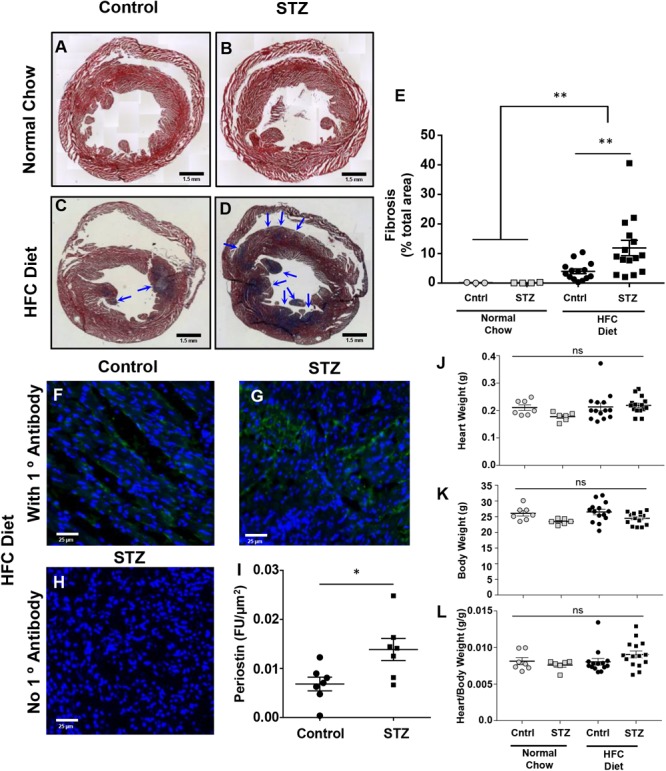
Effects of STZ- treatment on myocardial fibrosis in HFC diet fed SR-B1-KO/hypoE mice. Representative composite images of cardiac cross sections from (A) control- and (B) STZ-treated mice fed the normal chow diet and analyzed 14 weeks after the start of treatment, or (C) control- and (D) STZ-treated mice fed the HFC diet beginning 3 weeks after the start of treatment and analyzed after 4 weeks of HFC diet feeding. Sections are stained with Mason’s trichrome – healthy myocardium stains red and collagen stains blue (arrows). Scale bars represent 1.5 mm. (E) Quantification of average fibrotic (blue) area per section. Representative images of periostin staining (green) of cardiac sections from (F) control- and (G) STZ-treated mice fed the HFC diet beginning 3 weeks after the start of treatment and analyzed after 4 weeks of HFC diet feeding. (H) Control section of heart from an STZ-treated mouse fed the HFC diet in which the primary anti-periostin antibody was left out. Sections were counterstained with DAPI (blue). Scale bars represent 25 μm. (I) Quantification of periostin staining intensity per cardiac cross-sectional area for control- or STZ-treated mice that had been fed the HFC diet. (J) Heart weights, (K) body weights, and (L) heart/body weight ratios for control-treated (circles) and STZ-treated mice (squares) either maintained on the normal chow diet for 14 weeks after control/STZ-treatment (gray symbols) or fed the HFC diet for 4 weeks, beginning 3 weeks after control/STZ-treatment (black symbols). Each symbol in E and I–L represents an individual mouse. Means ± SEM are indicated by the horizontal lines and error bars. Data in E and J–L were analyzed by one-way ANOVA with Tukey’s multiple comparisons test and data in I were analyzed by the Mann–Whitney rank sum test; ns indicates not statistically significantly different (p > 0.05; ∗p = 0.018; ∗∗p = 0.005).